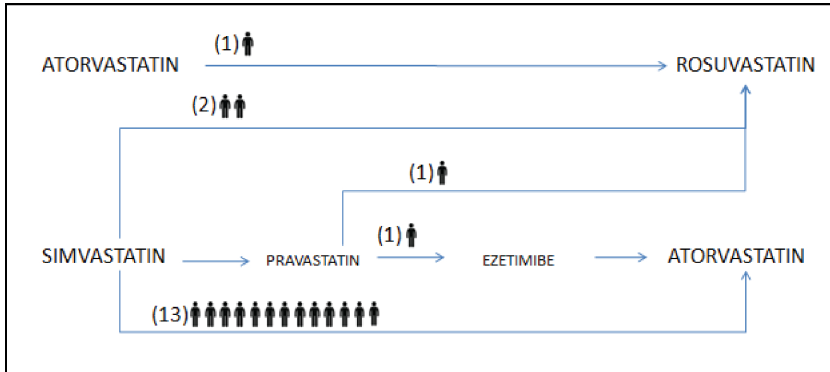
FIGURE 3 - Schematic diagram illustrating statin therapy substitutions in dyslipidemic Braz. J. Pharm. Sci. 2017;53(4):e00199